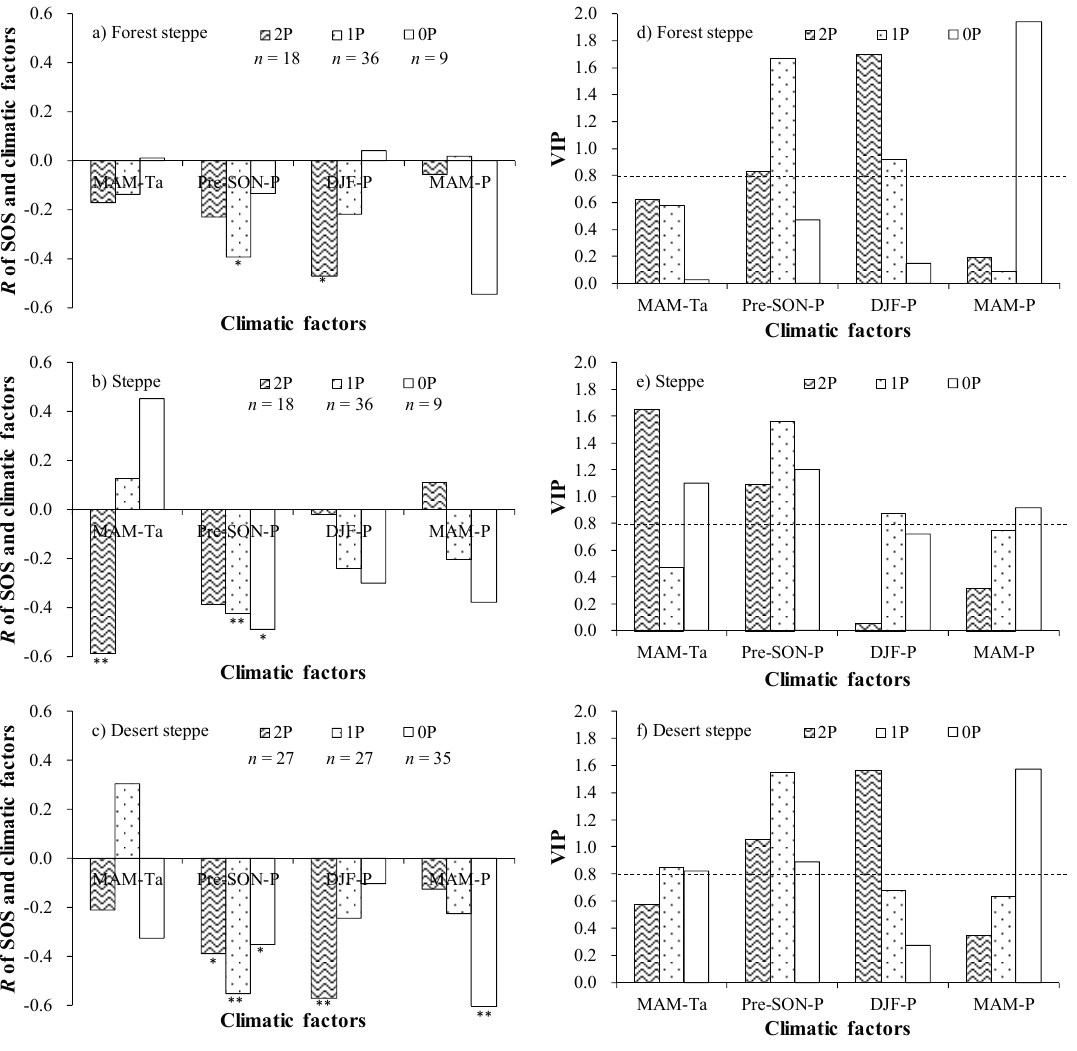
Figure 5. Correlation ( a–c ) between SOS and climatic factors for the three grassland types with three frozen ground types and VIP ( d–f ) for considered variables. * indicates the significance level of 0.05 and ** indicates the significance level of 0.01. The n is the number of phenological records for SOS. The 0P, 1P, and 2P represent seasonal frozen ground, sporadic permafrost, and permafrost,